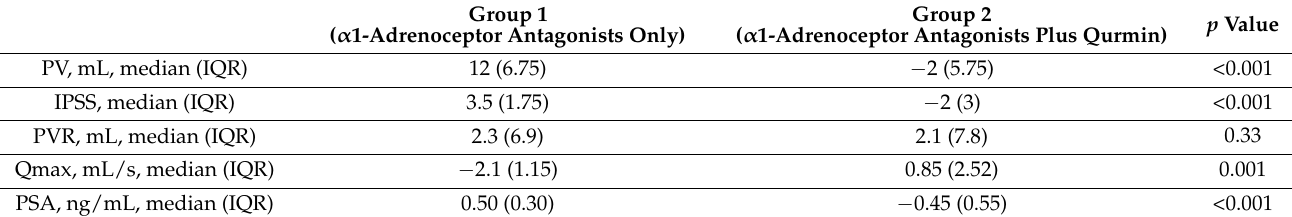
Table 3. Difference from baseline value at one-year follow-up. IQR: interquartile range. PSA: prostate-specific antigen. PV: prostate volume. IPSS: International Prostate Symptom Score. PVR: post-voiding